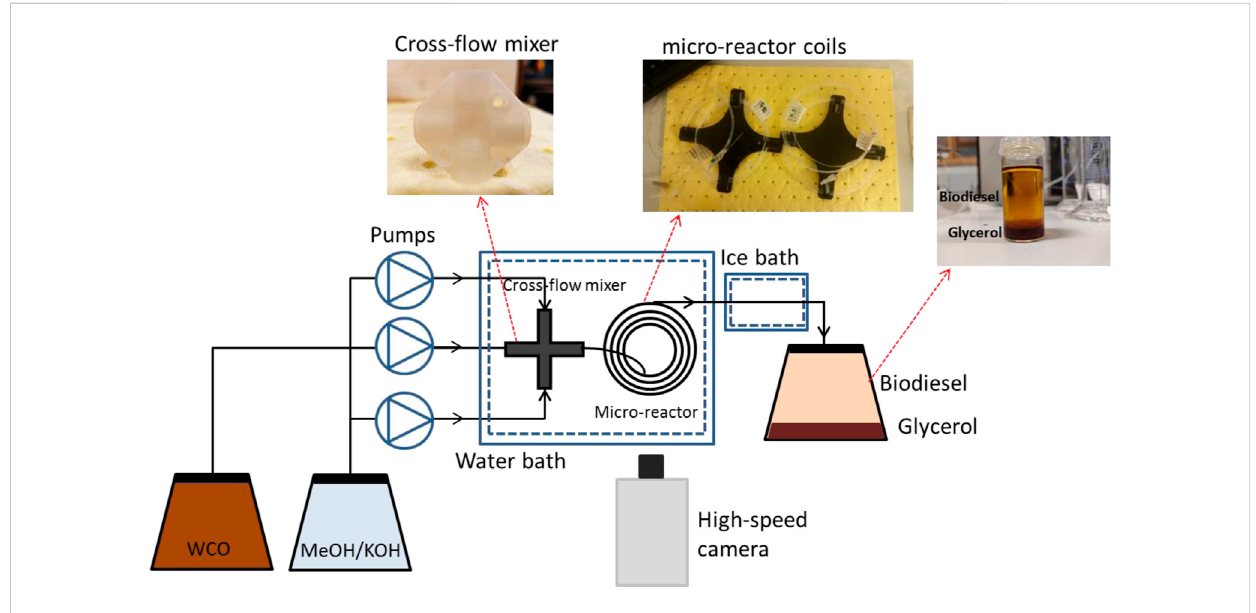
FIGURE 1 Schematic representation and photographs of the test rig.